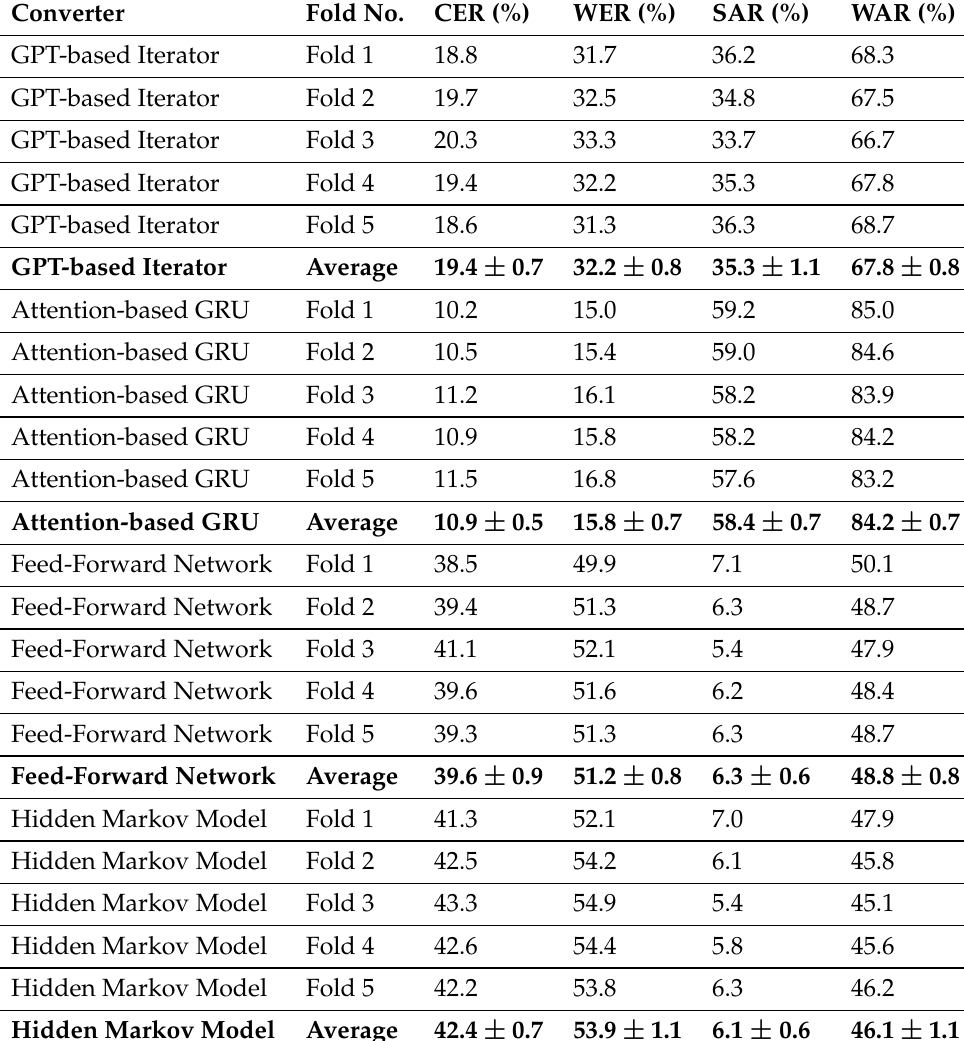
Table 5. Performance of viseme-to-word converters for Situation 1 on the LRS3 dataset.